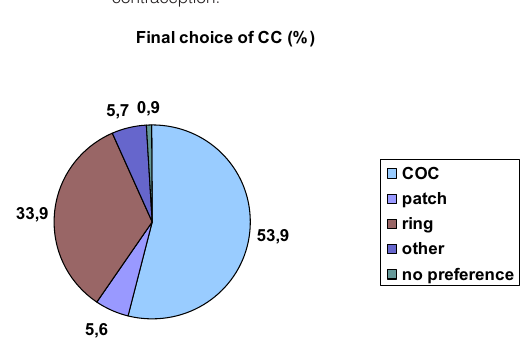
Figure 3. Selected route of administration of combined hormonal